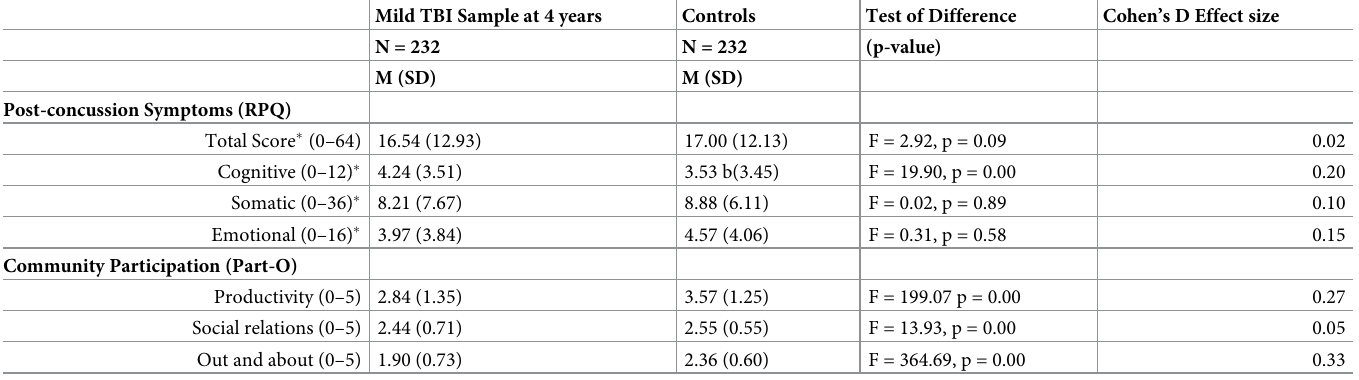
Table 2. Mean scores on the outcome measures between the two